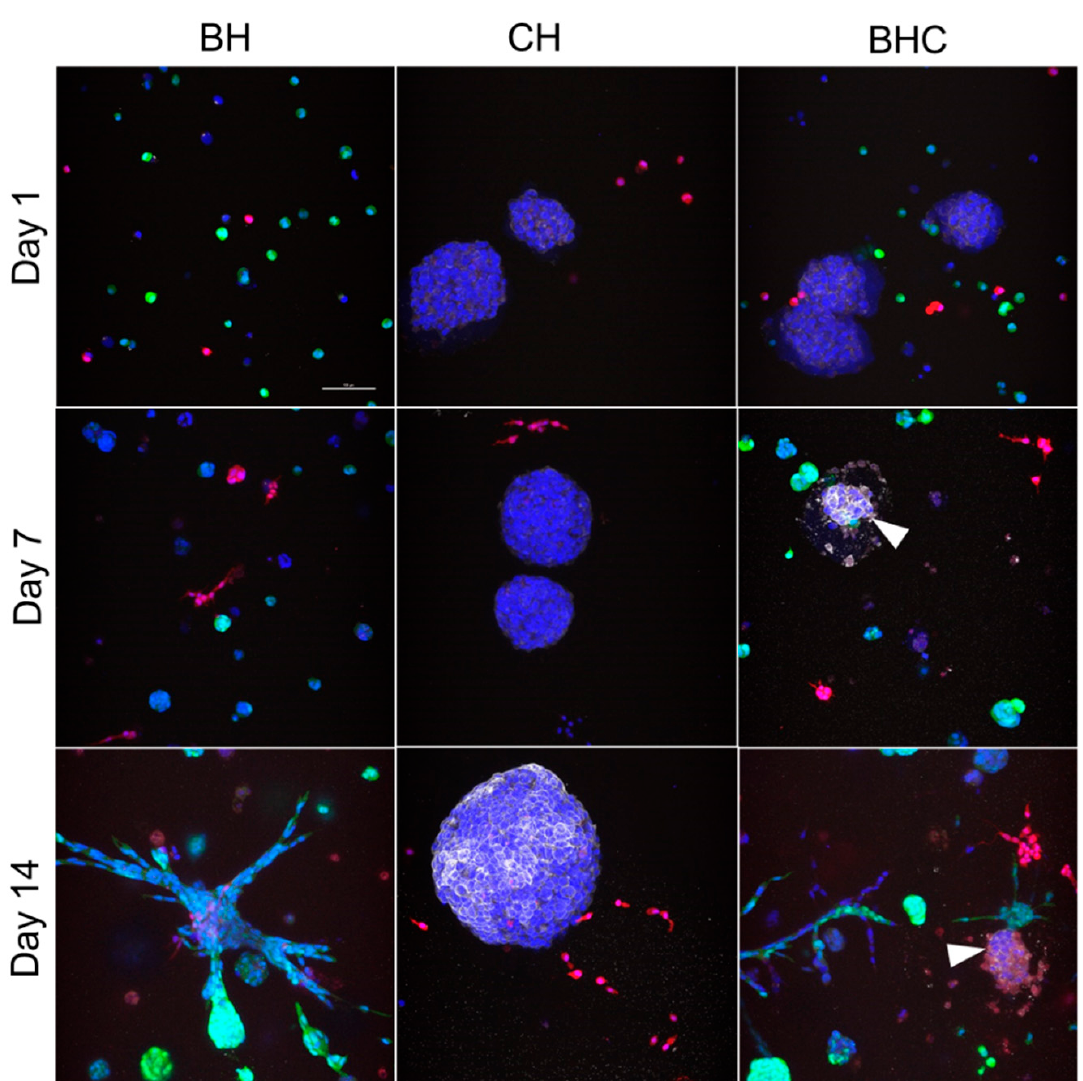
Figure 2. Triculture of BMEC, HS27a, and pre-clustered C4-2B induces a cell death/dormancy phenotype in C4-2B. BMEC-GFP (green), HS27a-RFP (red), and C4-2B pre-clustered into ~100 µm tumoroids were encapsulated in co- and tricultures. BMEC + HS27a (BH), C4-2B + HS27a (CH), and BMEC + HS27a + C4-2B (BHC) gels were fixed with 4% paraformaldehyde on days 1, 7, and 14 and stained with EpCAM (white) to label epithelium-derived PCa cells and DAPI (blue) to label nuclei. Scale bar = 100 µm for all figures.